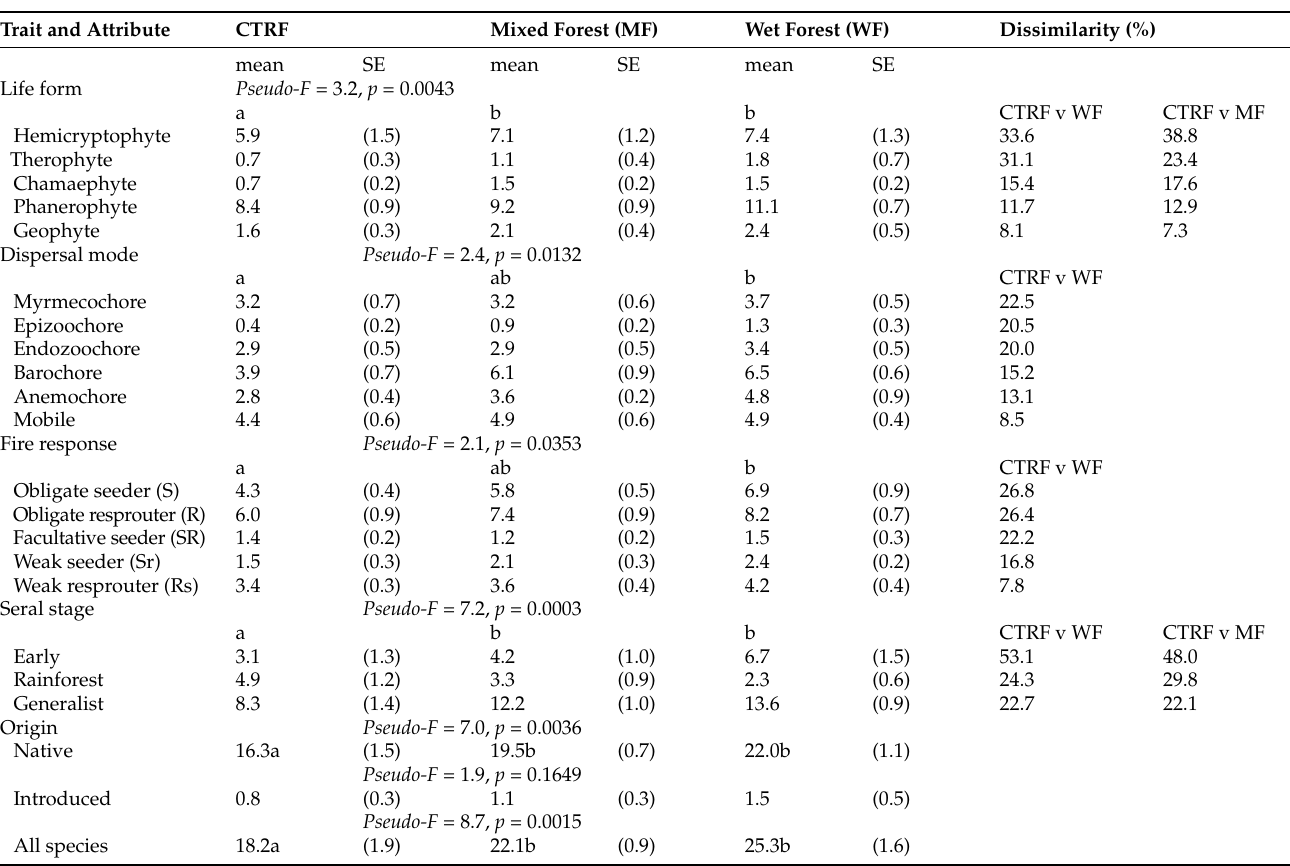
Figure 5. Venn diagram showing the number of unique and shared species among the three forest types. Numbers represent the combined pool of species in extant vegetation and soil seed bank. Solid color = cool temperate rainforest; Diagonal fill = mixed forest; No fill = wet forest. Table 4. Mean number of species per site (across both vegetation pools) with each attribute per forest type and the mean contribution to dissimilarity between forest types as determined by SIMPER tests (following PERMANOVA, Pseudo-F and p values shown). Attributes are ordered according to their contribution to dissimilarity. Letters indicate significant pairwise differences ( p ≤ 0.05). CTRF, cool temperate